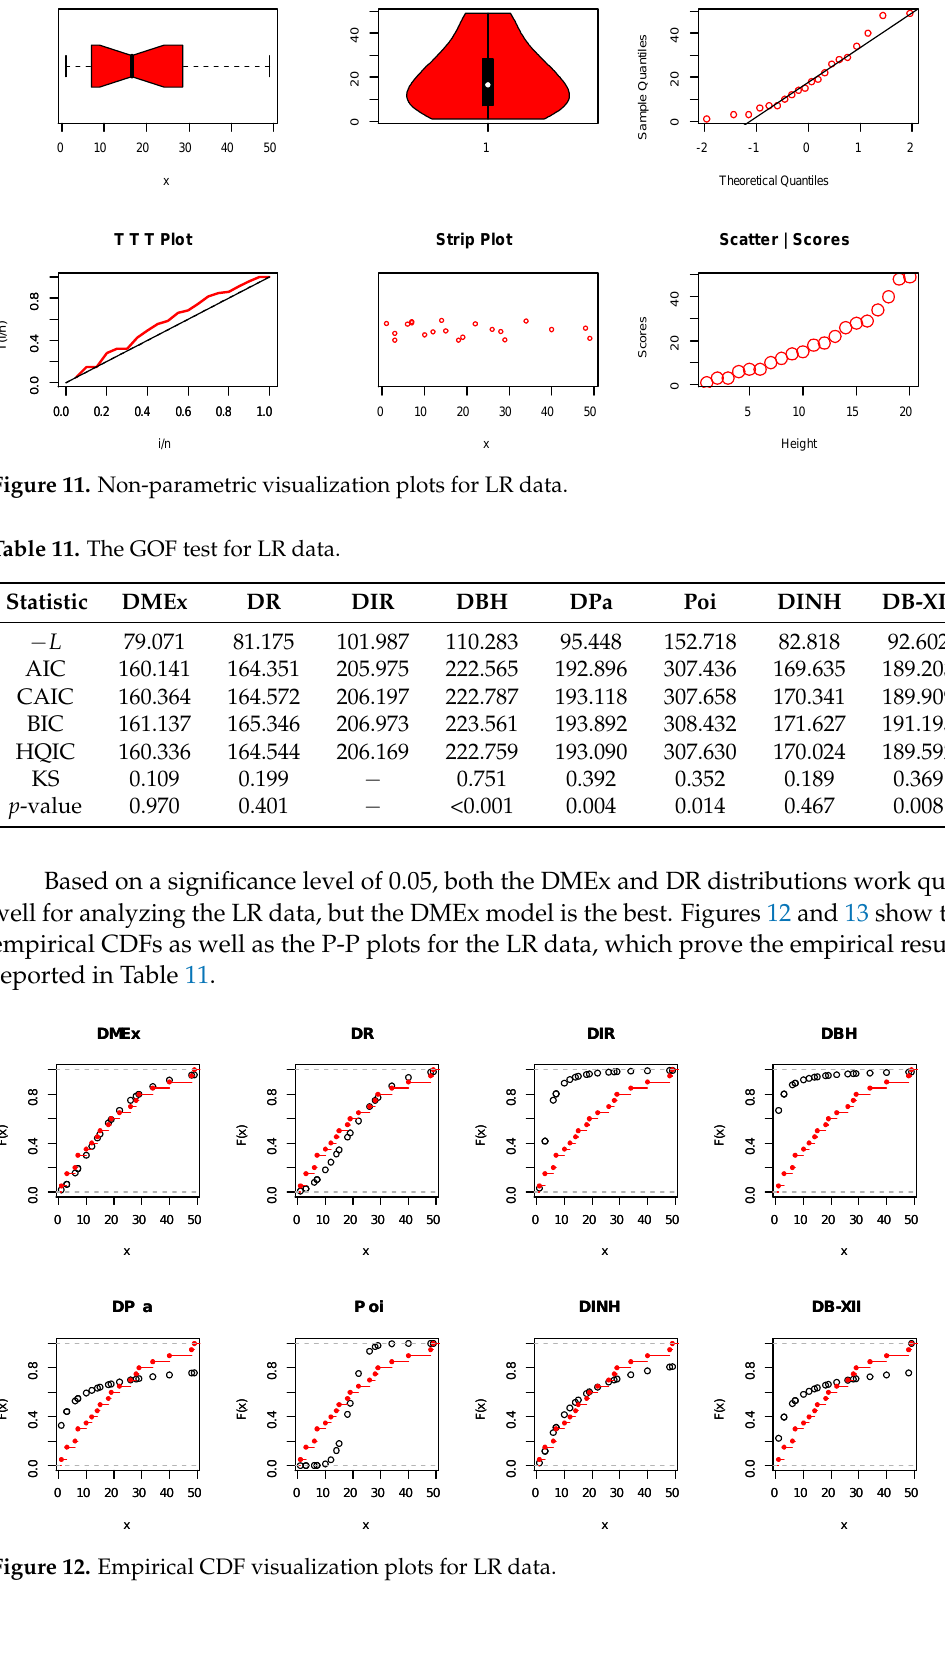
Figure 12 . Empirical CDFs visualization plots for LR data. Figure 12. Empirical CDF visualization plots for LR